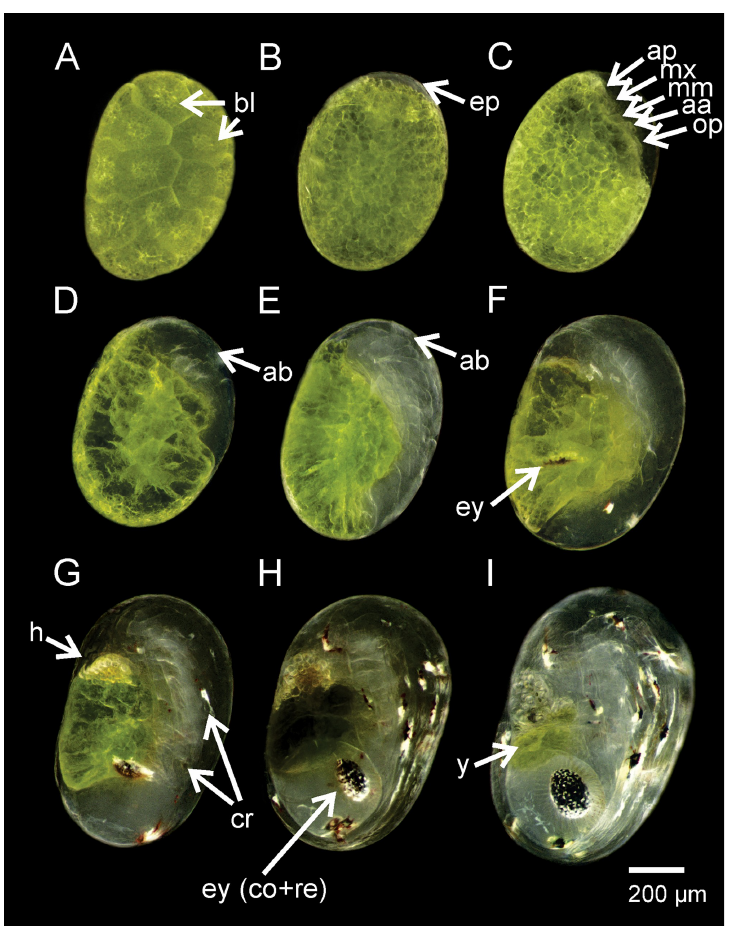
Fig 4. Embryonic development of Lysmata vittata (Stimpson, 1860). (A) Recently laid eggs. (B) Embryonic primordium. (C) Embryo with differentiated structures. (D) Abdomen and cephalothorax are differentiated. (E) Abdomen is enlarged and its segmentation is almost complete. (F) Eyes are developing. (G) Appearance of chromatophores. (H) Eyes are differentiated into cornea and retina. (I) Embryo is close to hatching. aa = antennule- antenna lobe; ab = abdomen; ap = abdomen primordium; bl = blastomere; cr = chromatophores; ep = embryonic primordium; ey = eye; ey (cornea and retina) = eye is differentiated into cornea and retina; h = heart; mm = maxillule- maxilla lobe; mx = maxilliped lobe; op = optic lobe; y =